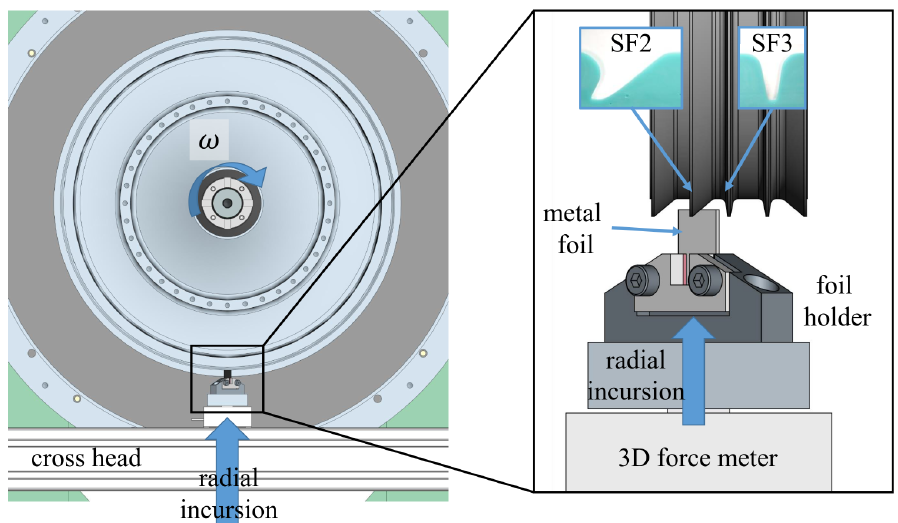
Figure 2. Setup of the test rig: A traversing cross head causes the radial incursion of the metal foil onto the five possible seal fins with two different geometries (slanted SF2, perpendicular